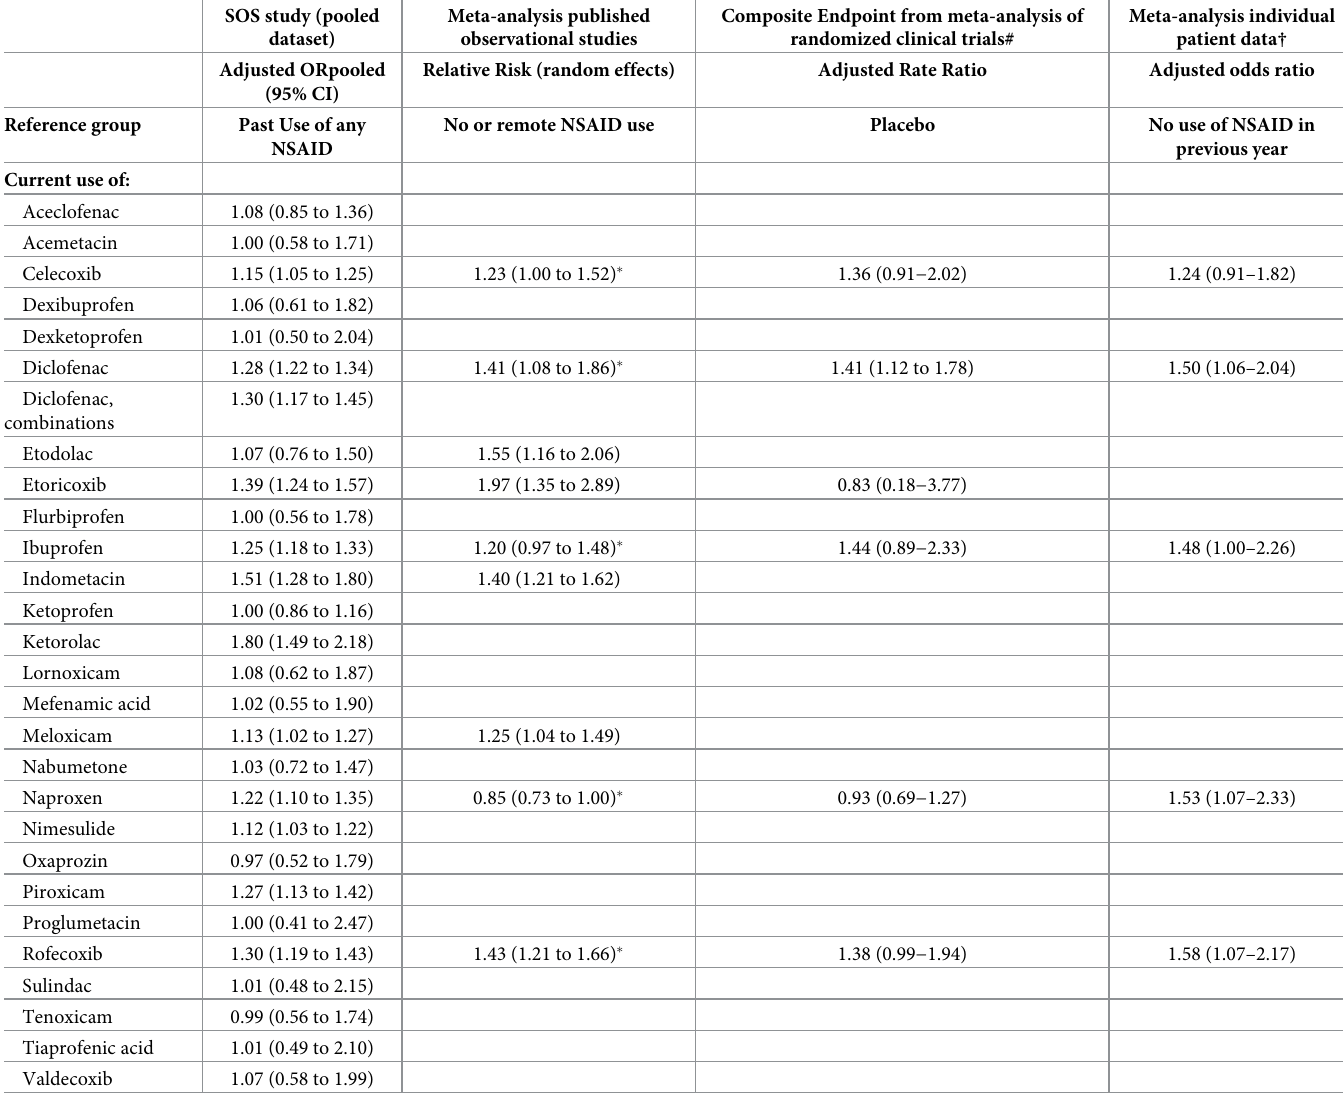
Table 3. Risk estimates of AMI for individual NSAIDs from current SOS study, meta-analysis from observational studies[12] and randomized clinical trials[13], using major vascular events as outcome. SOS study (pooled